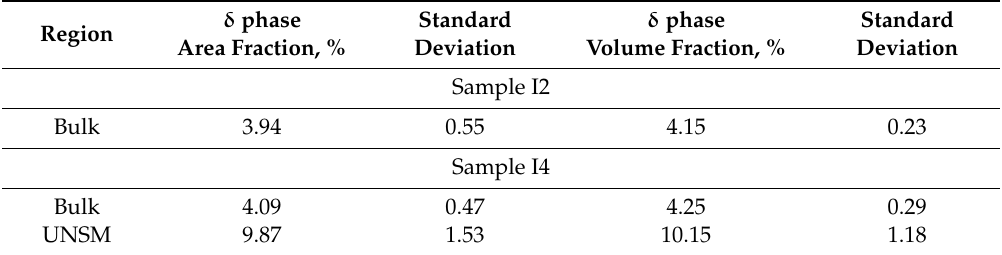
Table 5. δ phase area and volume fraction coverage for Samples I2 and I4.